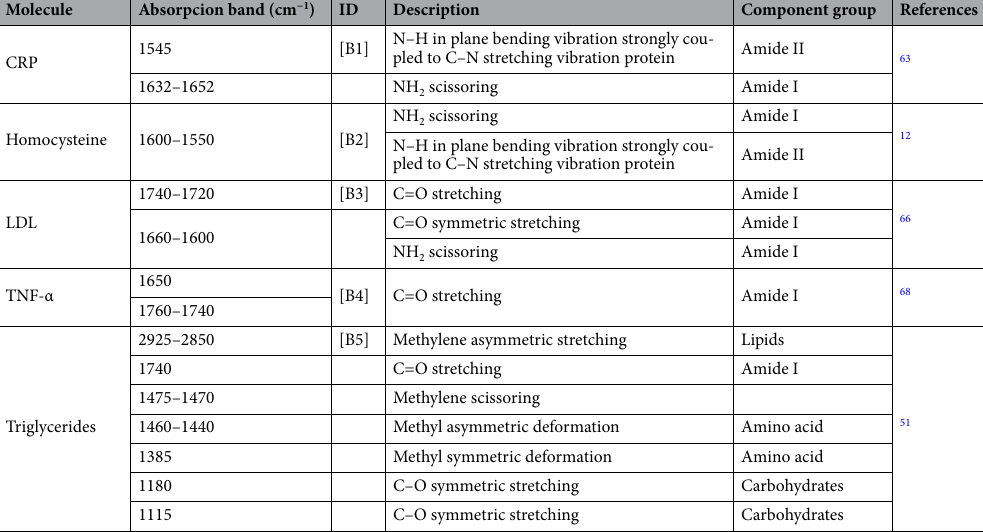
Table 2. Identified reference molecules included in the composition of IR spectra of tested human sera. ID symbol shows representative characteristic fragment of infrared spectrum, of human serum, for the molecules differentiating the study groups presented on Fig. 1a,b: patients with coronary heart disease (CHD) infected with H. pylori , healthy donors non-infected or infected with H. pylori . B band, CRP C-reactive protein, LDL low density lipoprotein, TNF-α tumor necrosis factor alpha.